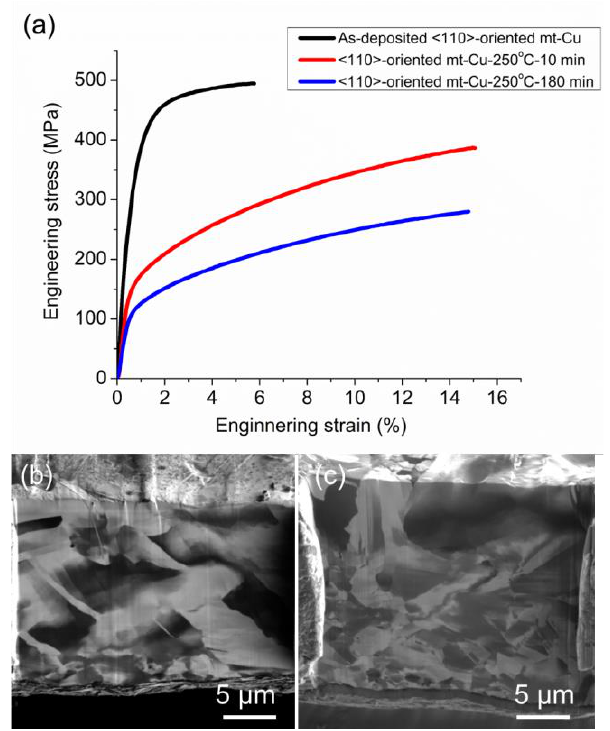
Figure 3. Microstructure of the copper foils. These figures show ( a ) the cross-sectional ion images; ( b ) TEM image, average twin spacing of 35 nm; ( c ) plane view EBSD of <111>-oriented nt-Cu foil, average grain size of 0.8 μm. Low-angle grain boundary, high-angle grain boundary, and twin boundary are marked in green lines, black lines, and red lines, respectively.